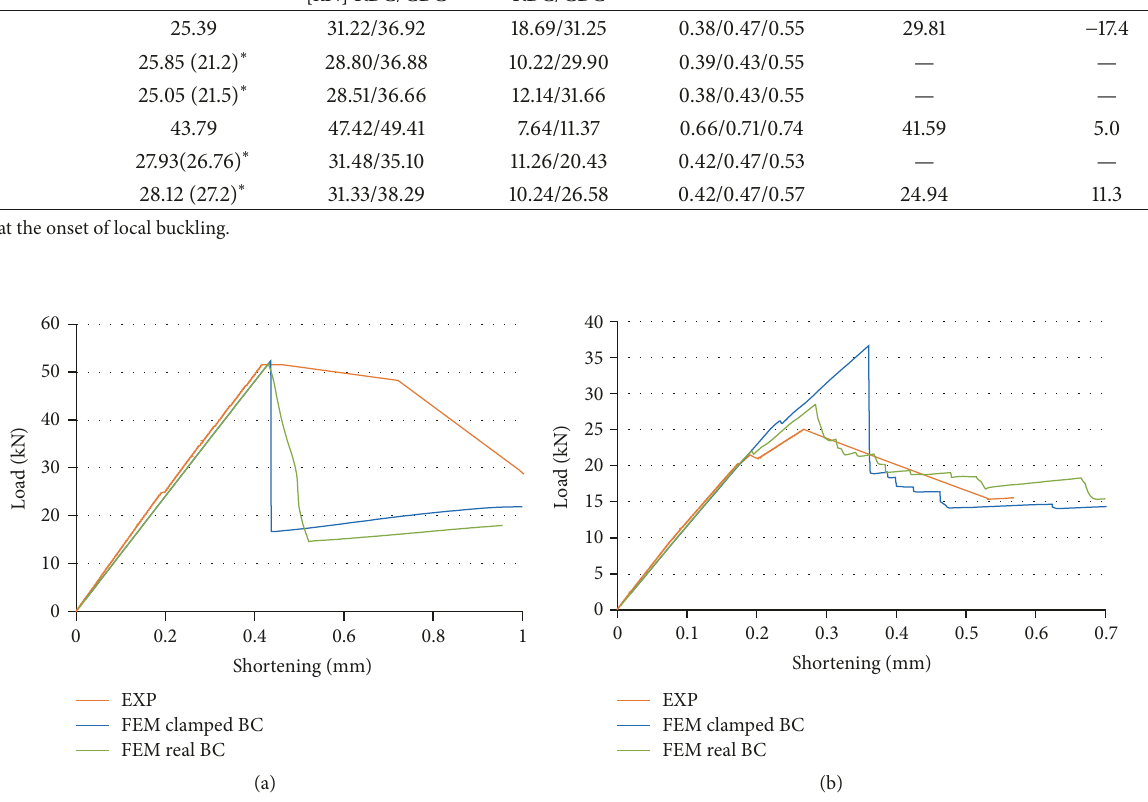
vibration mode monitored during axial compression for either the intact cylinders (cf. Figure 8(a) and Table 2) or the cylinders with cutouts (cf. Figure 8(b) and Table